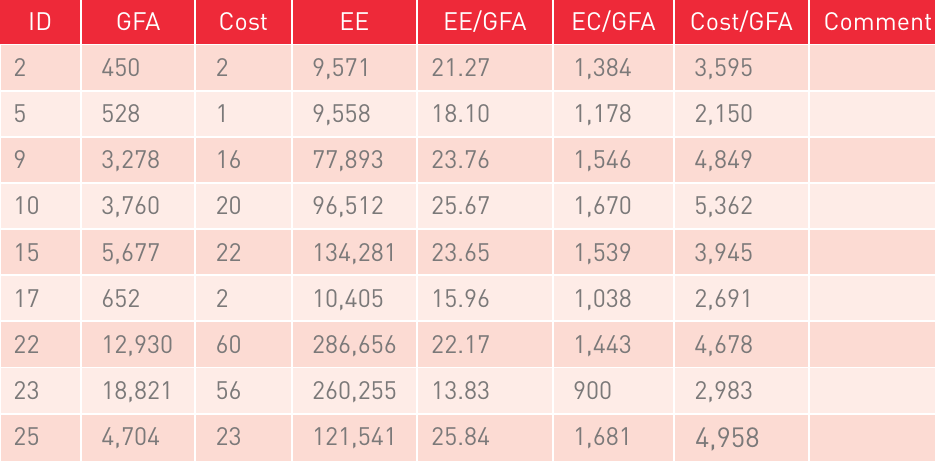
Refurbished projects